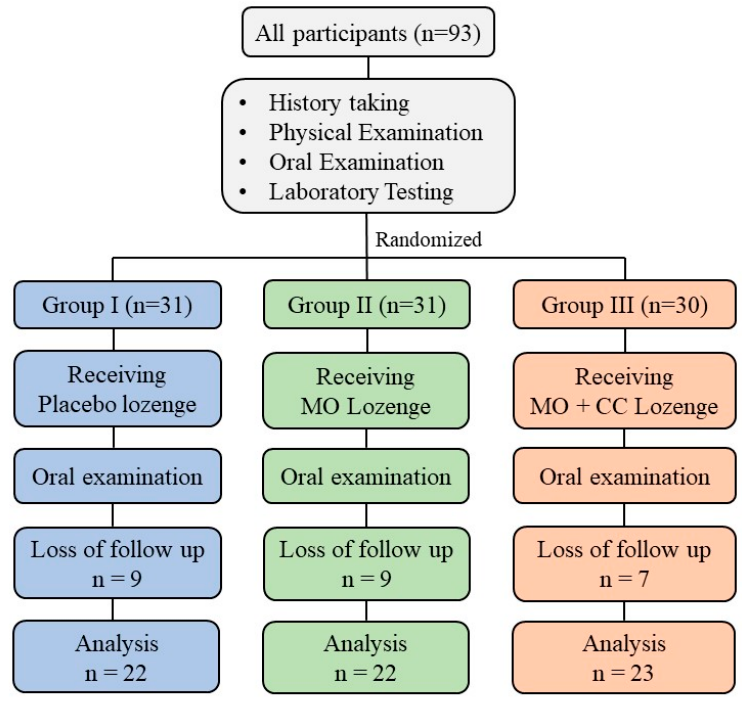
Figure 3. Study Figure 3. Study design.